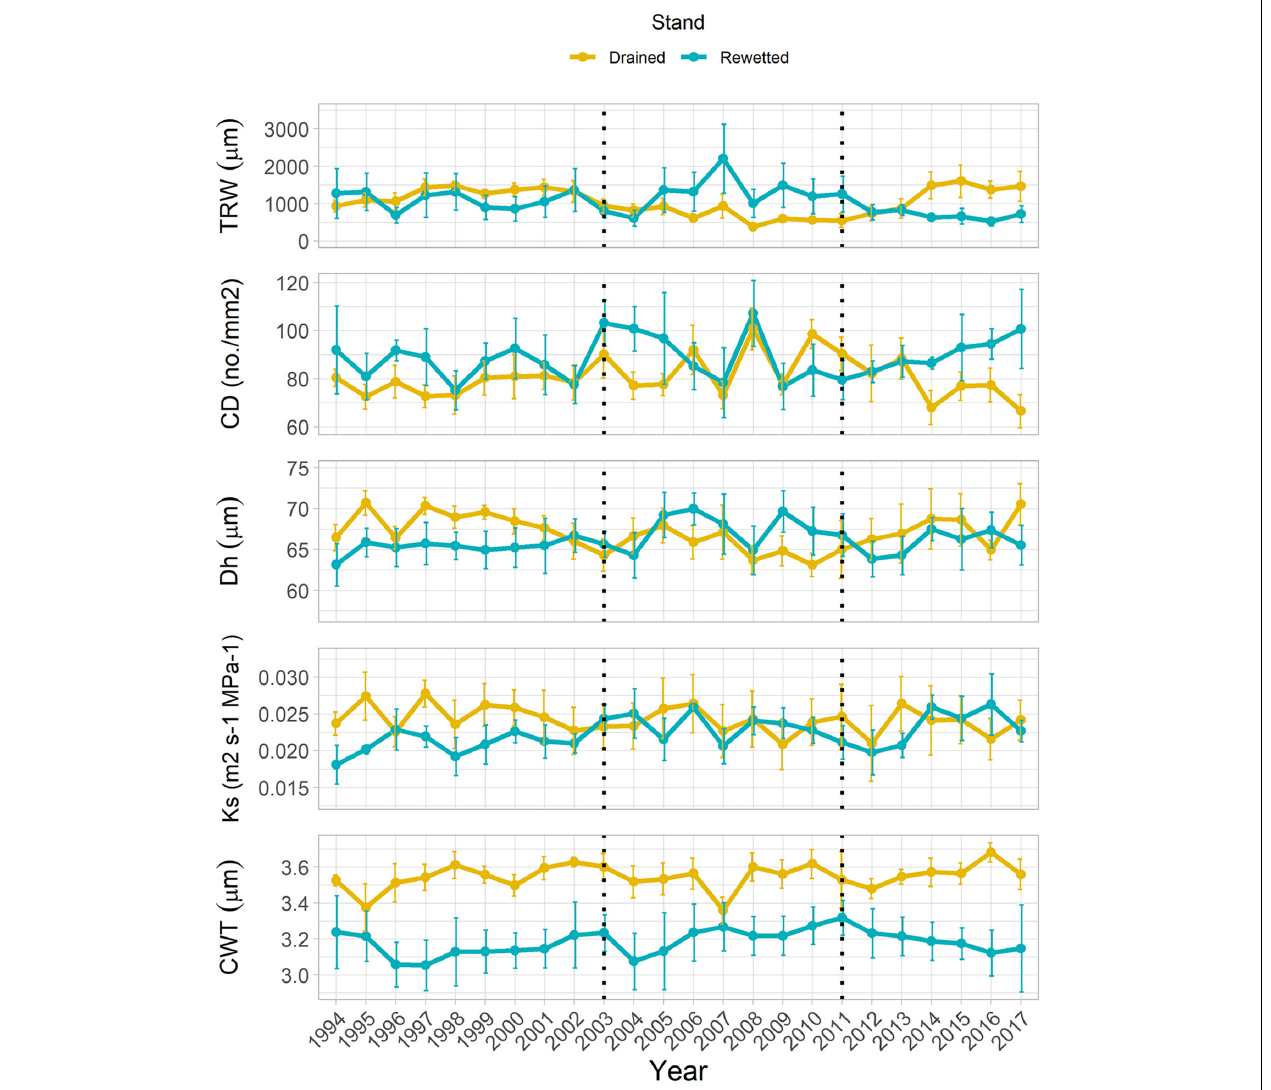
FIGURE 3 | Tree-ring width (TRW), vessel density (number of vessels per area, CD), hydraulically weighted mean vessel diameter (Dh), xylem-specific hydraulic conductivity (Ks) and cell wall thickness (CWT) of fibers in the study stands (means ± SE). Vertical dotted lines indicate the year of rewetting (2003) and the year of extreme flooding